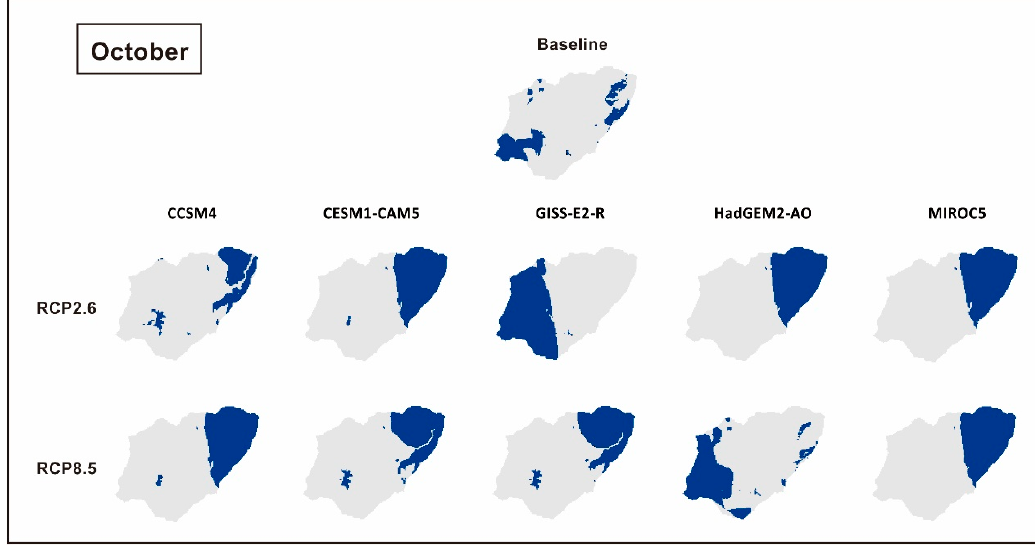
Figure 10. Hotspot spatial distribution of water yield in October.